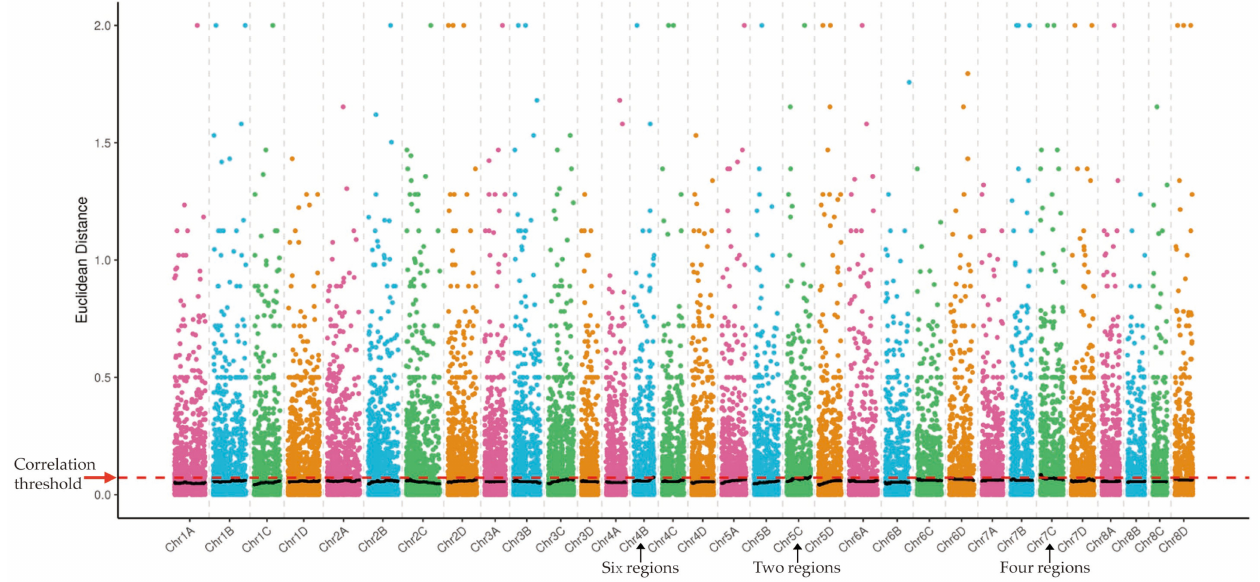
Figure 2. The distribution of correlation thresholds of Euclidean distance (ED) algorithm on the chromosome of Saccharum spontaneum . The abscissa is the chromosome name and the ordinate is the ED value; the colored dots represent the ED value of each SNP locus on the chromosome, the black line represents the fitted ED value, and the red arrow represents the correlation